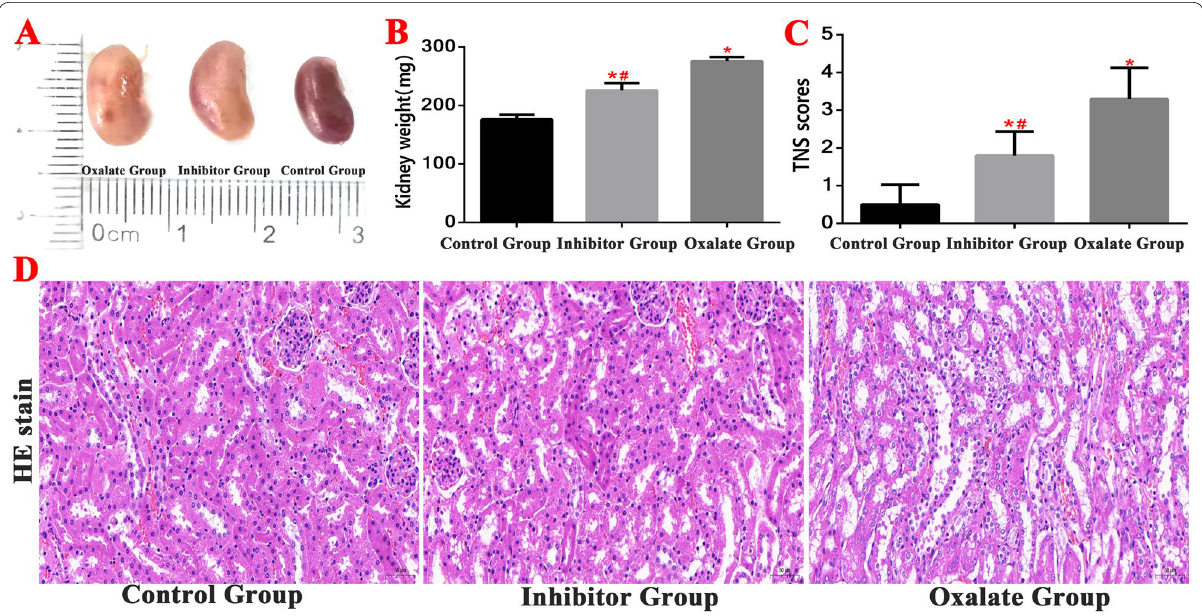
Fig. 2 Detection of kidney tissue damage in Kidney stone model. A , B Comparison of kidney weight detection of mice in each group. C , D HE staining was used to observe the kidney structure and compare the renal tubular injury scores of mice in each group. (* (Red) Compared with control group, P < 0.01. #(Red) Compared with oxalate group, P <